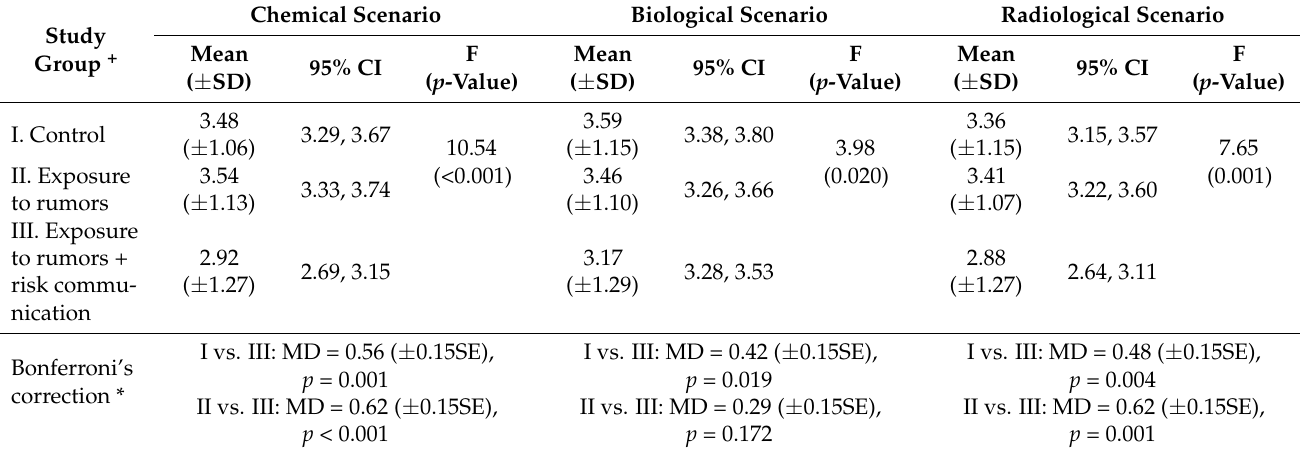
Table 4. Differences in the mean score of the behavioral intent to seek medical attention at the hospital following social media exposure to non-conventional terrorism reports, rumors, and risk communication.